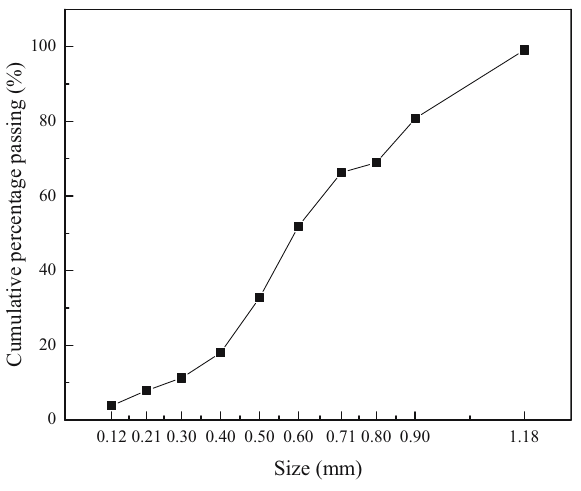
Figure 1: Particle size distribution of the silica sand.